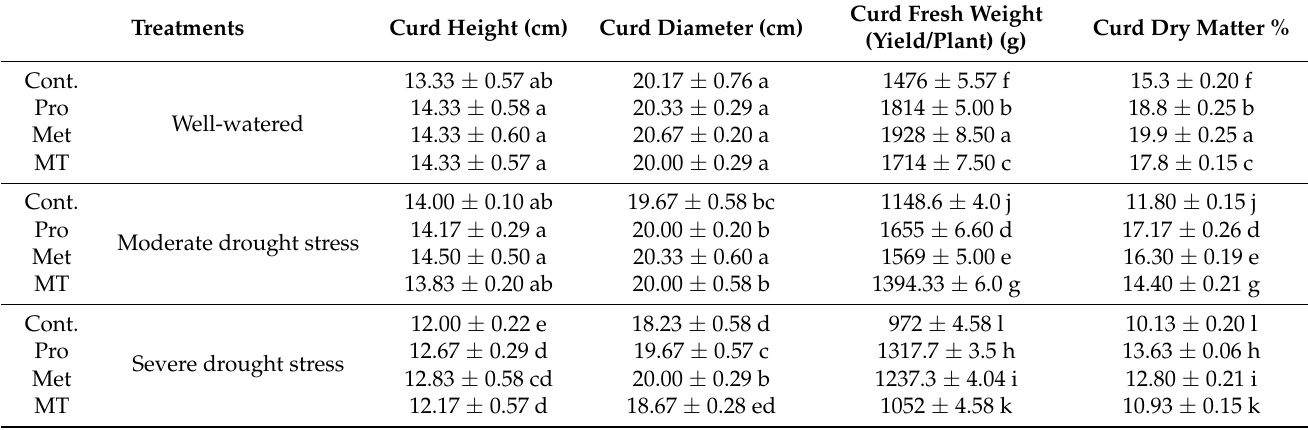
Table 2. Impact of interaction between treatments (proline, methionine, and melatonin) and water levels on curd height, curd diameter, curd fresh weight, curd dry matter, and total yield of cauliflower plants grown under drought. ± Value indicates standard error (SE) of the means (n = 6). Means followed by different letters point to significant differences between the treatments at according to Tukey’s multiple range test ( p ≤